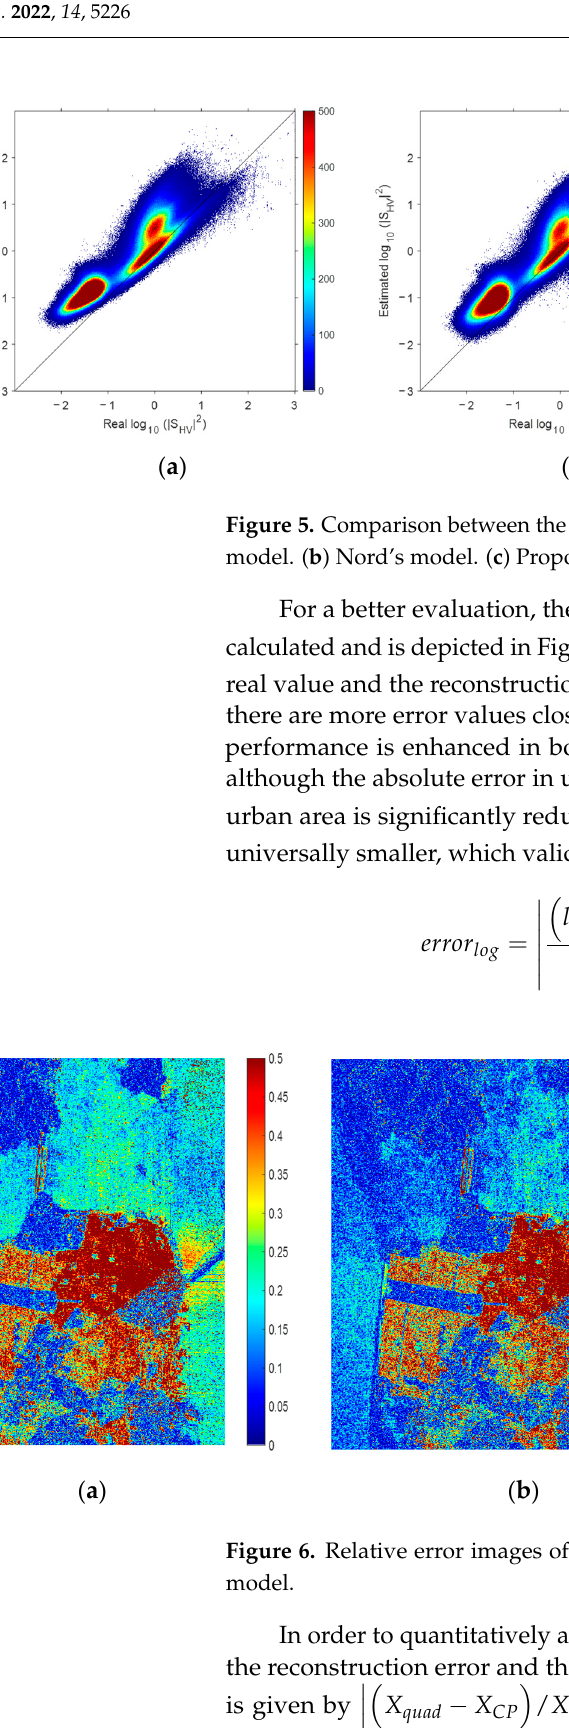
Figure 6. Relative error images of model.